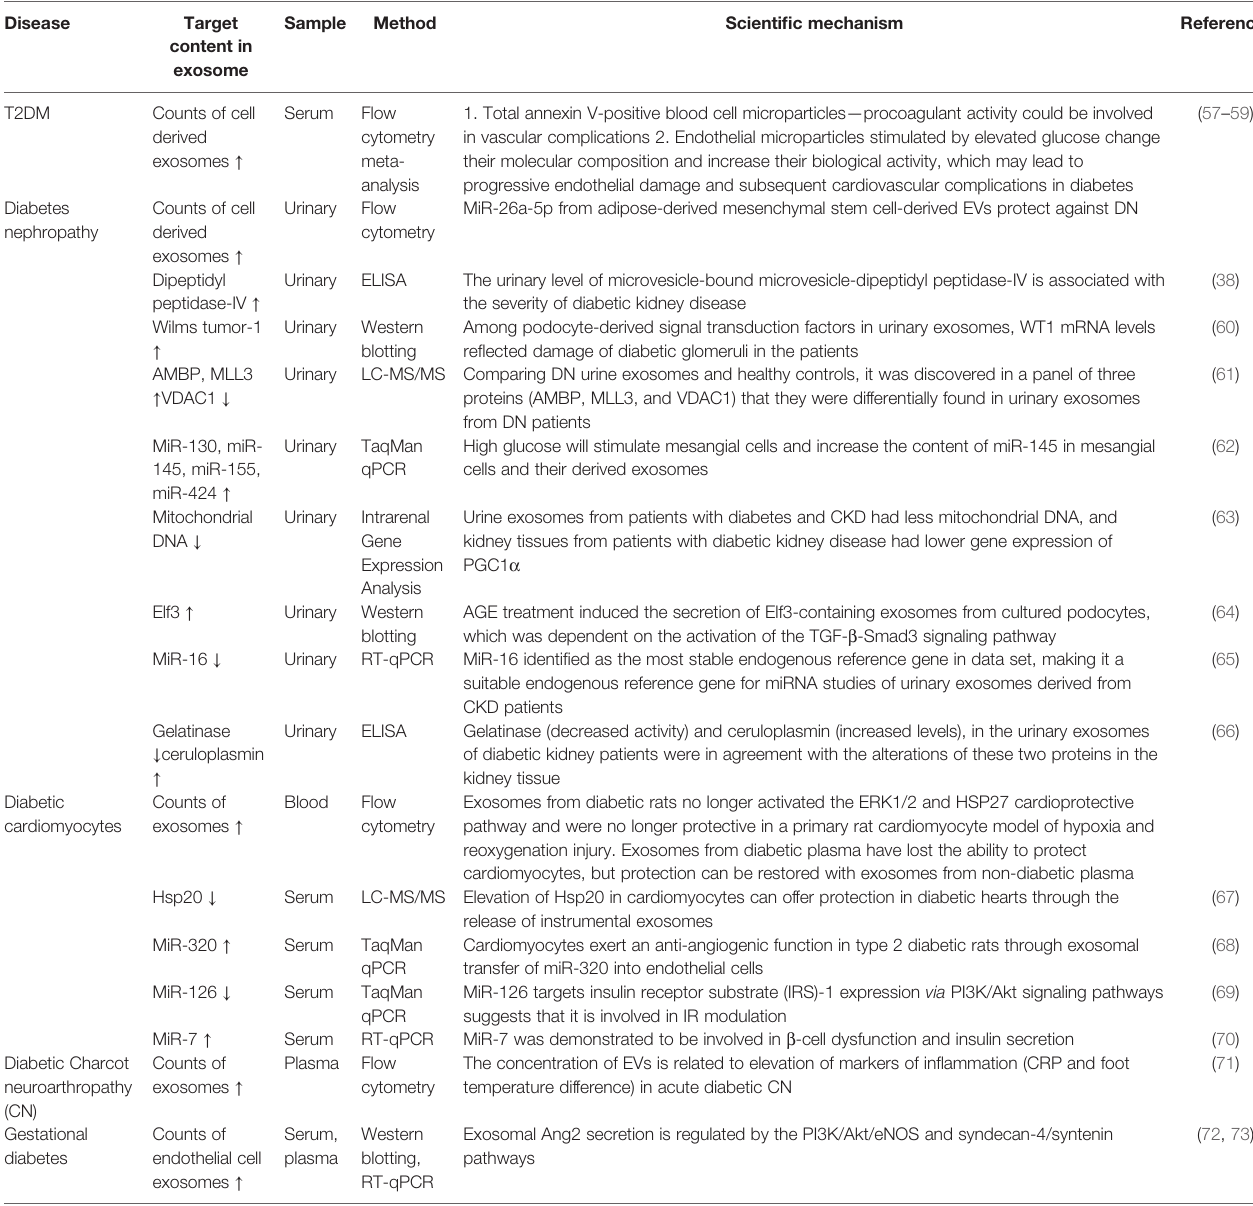
TABLE 2 | Exosomes derived from body fl uid can act as novel biomarkers for early diagnosis of DM and diabetic complications.